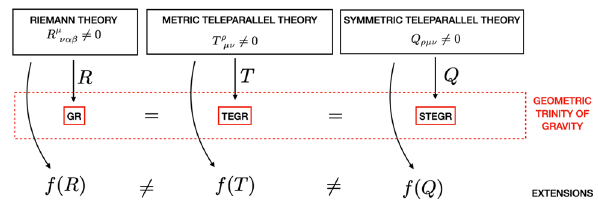
Fig. 3 The Geometric Trinity of Gravity and related extensions. The equivalenceholdsonlyfortheorieslinearinthescalarinvariants.Exten- sions can involve further degrees of freedom which lead to the breaking of equivalence among different representations of gravity. It can be restored identifying correct boundary